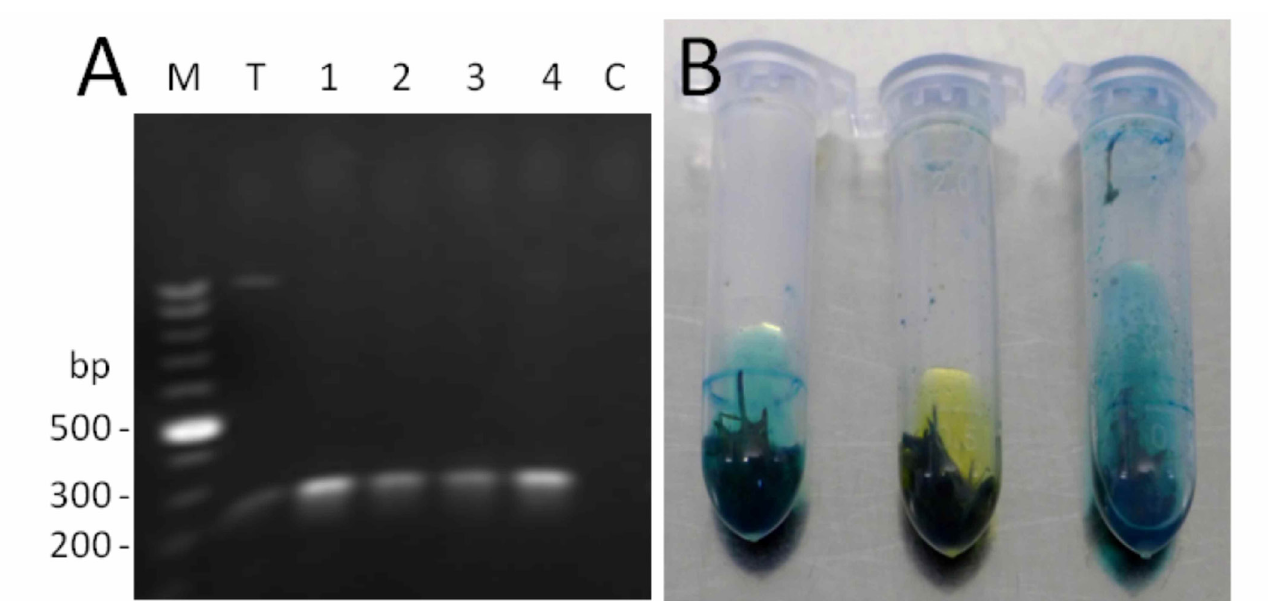
FIGURE 7 - Verification of horizontal gene transfer from A. rhizogenes to H. sinaicum hairy roots. Presence of the expected 198 bp PCR amplified fragment of aux1 gene in hairy roots after transformation with A. rhizogenes strains. Lane M - GeneRuler DNA Ladder Mix, lane T - reference DNA from tobacco transformed with the LBA1334, lanes 1-4 - DNA from H. sinaicum hairy roots after transformation with A4T, A4, LBA1334, and A4T-GUS, lane C - DNA from control, not transformed H. sinaicum plant (A). Blue staining resulting from the uidA gene transfer from the A4T-GUS A. rhizogenes strain to hairy roots and consecutive GUS activity. Unstained roots from the control, not transformed H. sinaicum plant are in the middle tube